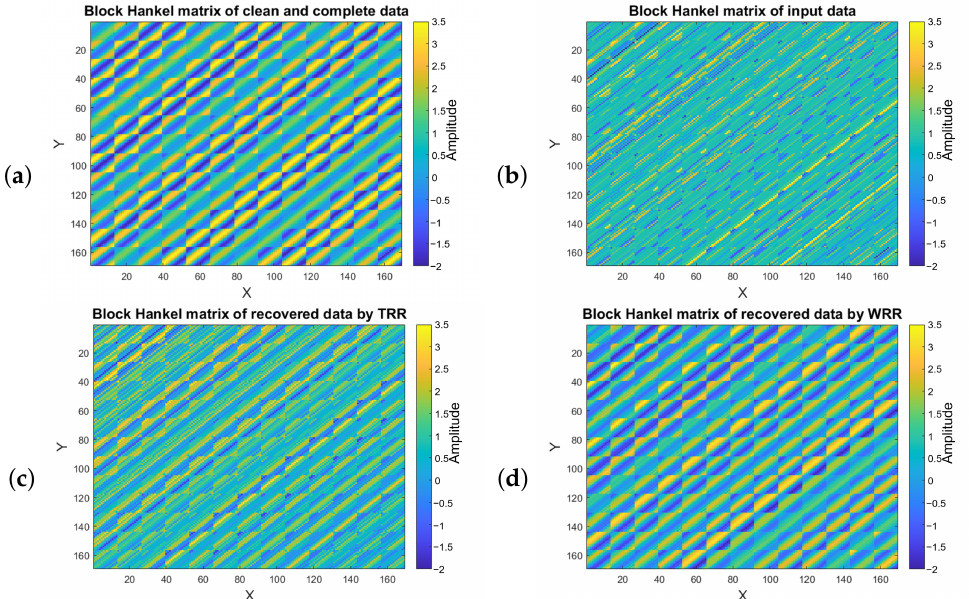
Figure 7. Block Hankel matrices for frequency of 20 Hz for ( a ) clean and complete data, ( b ) data with SNR = 2 and 51% missing traces, ( c ) data recovered by TSVD rank-reduction after ten iterations, ( d ) data recovered by WRR after ten